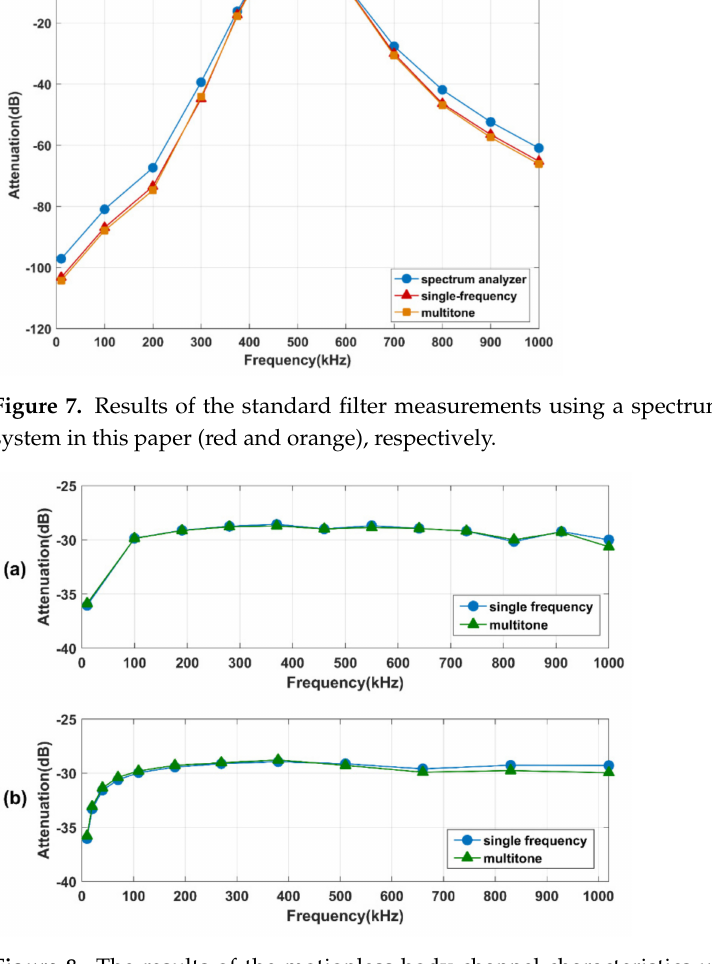
Figure 8. The results of the motionless body channel characteristics under linear ( a ) and quasi- logarithmic ( b )